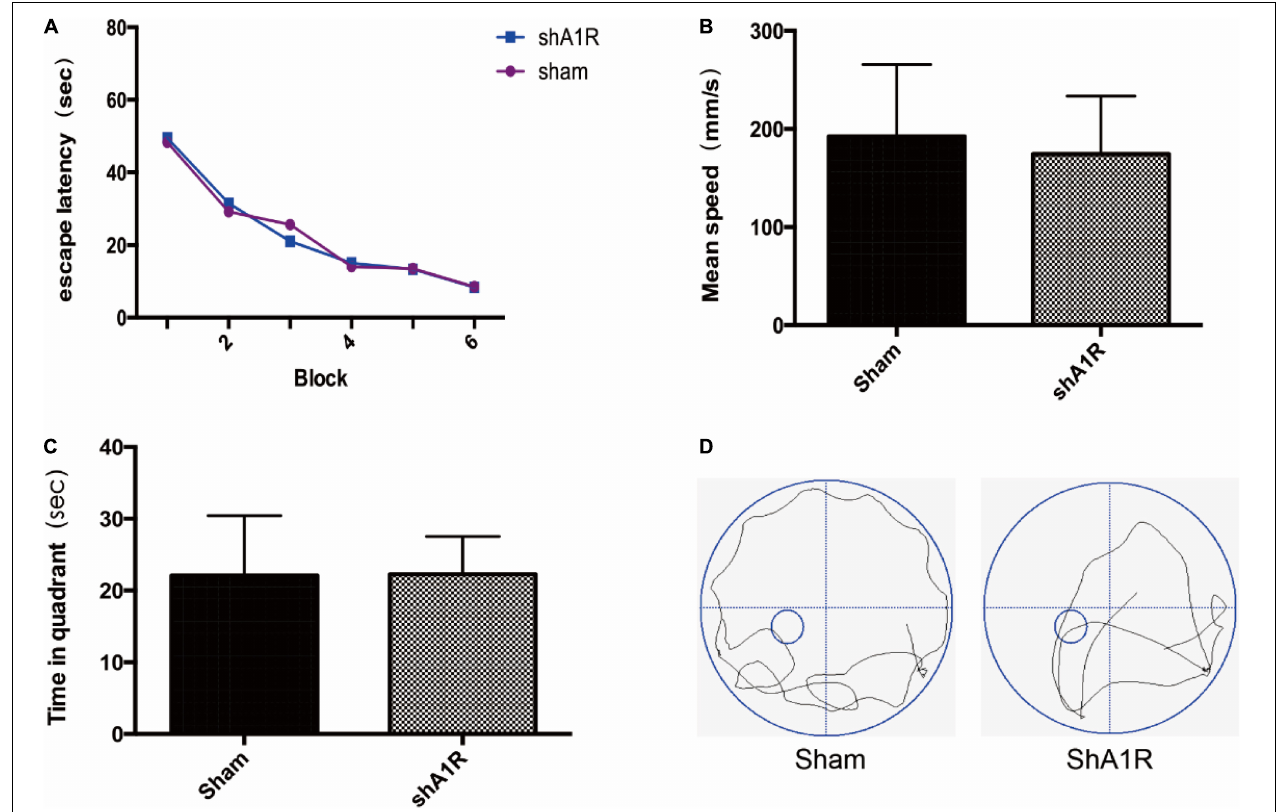
FIGURE 7 | Effects of AV-shA1R on cognitive function ( n = 6). (A) Changes in the escape latency during six-block acquisition trials; (B,C) effects of AV-shA1R on (B) mean speed and (C) time in quadrant. (D) The swimming tracks of rats in different conditions in the probe trial